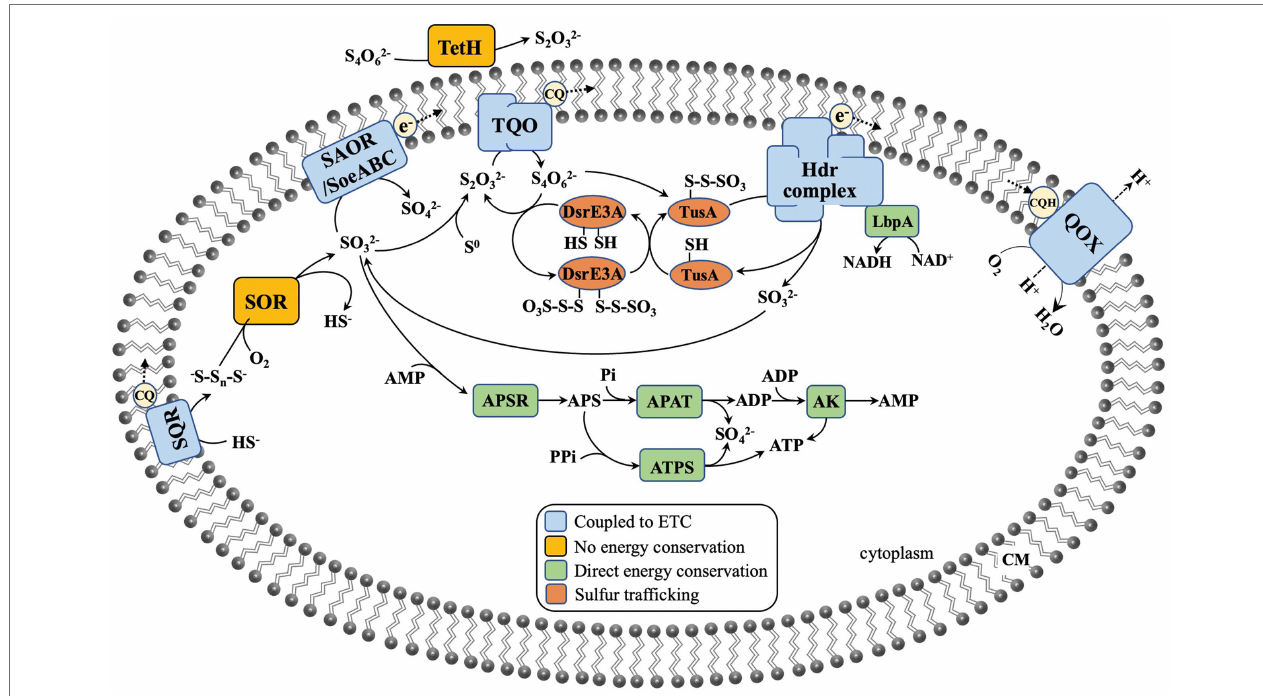
FIGURE 1 | The proposed sulfur oxidation pathway in Sulfolobales. SQR, sulfide:quinone oxidoreductase; SOR, sulfur oxygenase reductase; SAOR, sulfite: acceptor oxidoreductase; SoeABC, sulfite oxidizing enzyme; TetH, tetrathionate hydrolase; TQO, thiosulfate: quinone oxidoreductase; Hdr, heterodisulfide reductase; LbpA, lipoate-binding protein A; Dsr, disulfide reductase; Tus, tRNA 2-thiouridine synthesizing protein; APSR, APS reductase; APAT, adenylylsulfate: phosphate adenylyltransferase; ATPS, ATP sulfurylase; AK, adenylate kinase; CQ, caldariellaquinones; and QOX, quinone